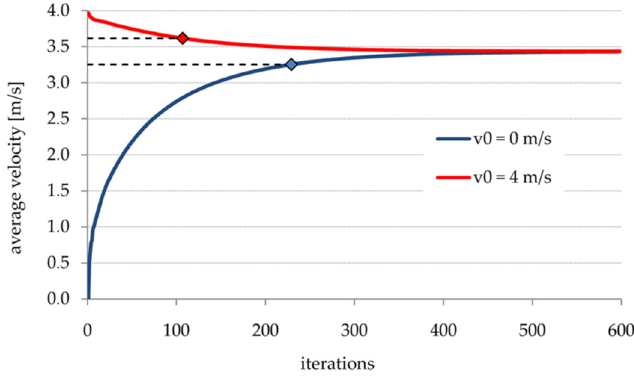
Figure 13. Velocity convergence for a simple model of a jet fan in a long